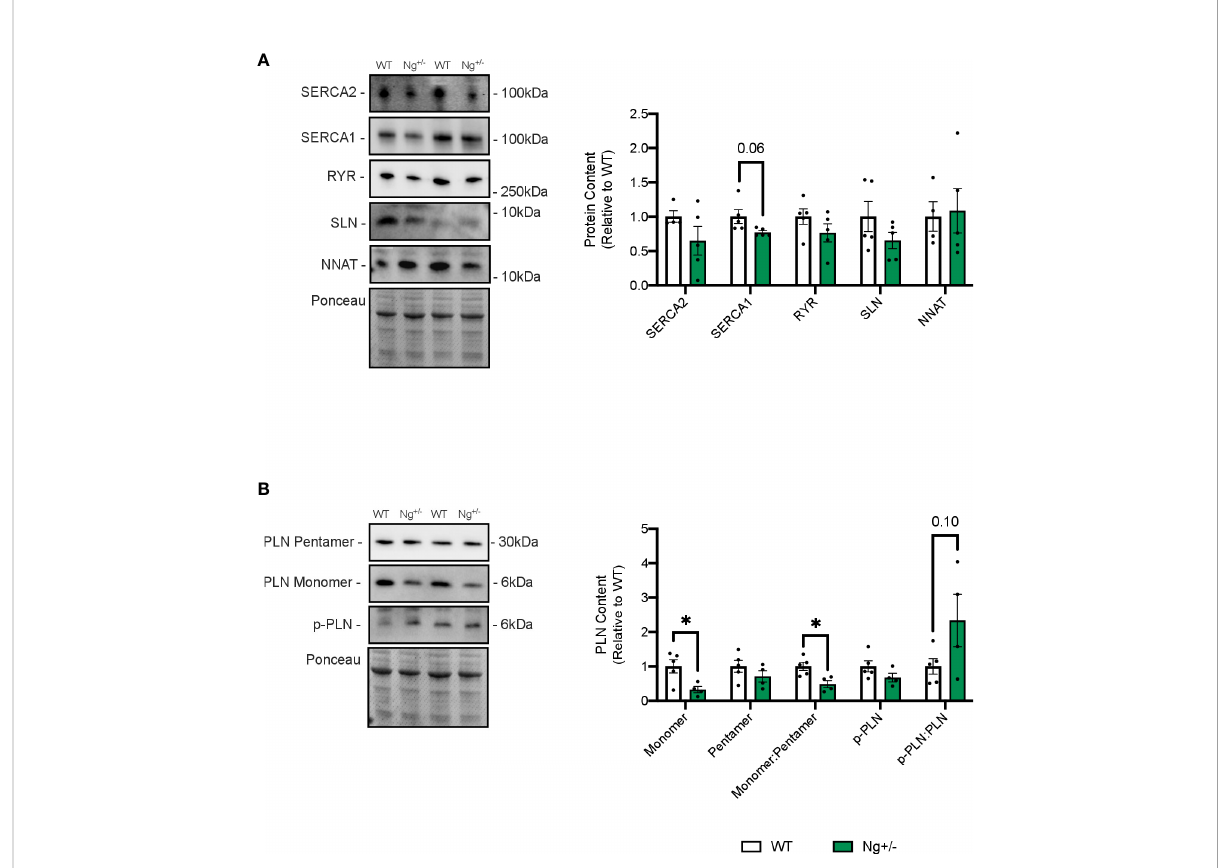
FIGURE 4 Phospholamban is reduced in the soleus muscles of Ng +/- mice. Representative Western blots and their corresponding analyses for SERCA2a, SERCA1a, RYR, SLN and NNAT in the soleus of WT and Ng +/- mice (A) . Only reductions in SERCA1a content were observed, though this did not reach statistical signi fi cance. Characterizing PLN and its activation status showed reductions in monomeric PLN resulting in reductions in the monomer:pentamer ratio and statistically insigni fi cant increases in the p-PLN : PLN ratio (B) . Molecular weight markers are included in the representative blots. * p < 0.05, values above bars indicate p values (n=4-5 per